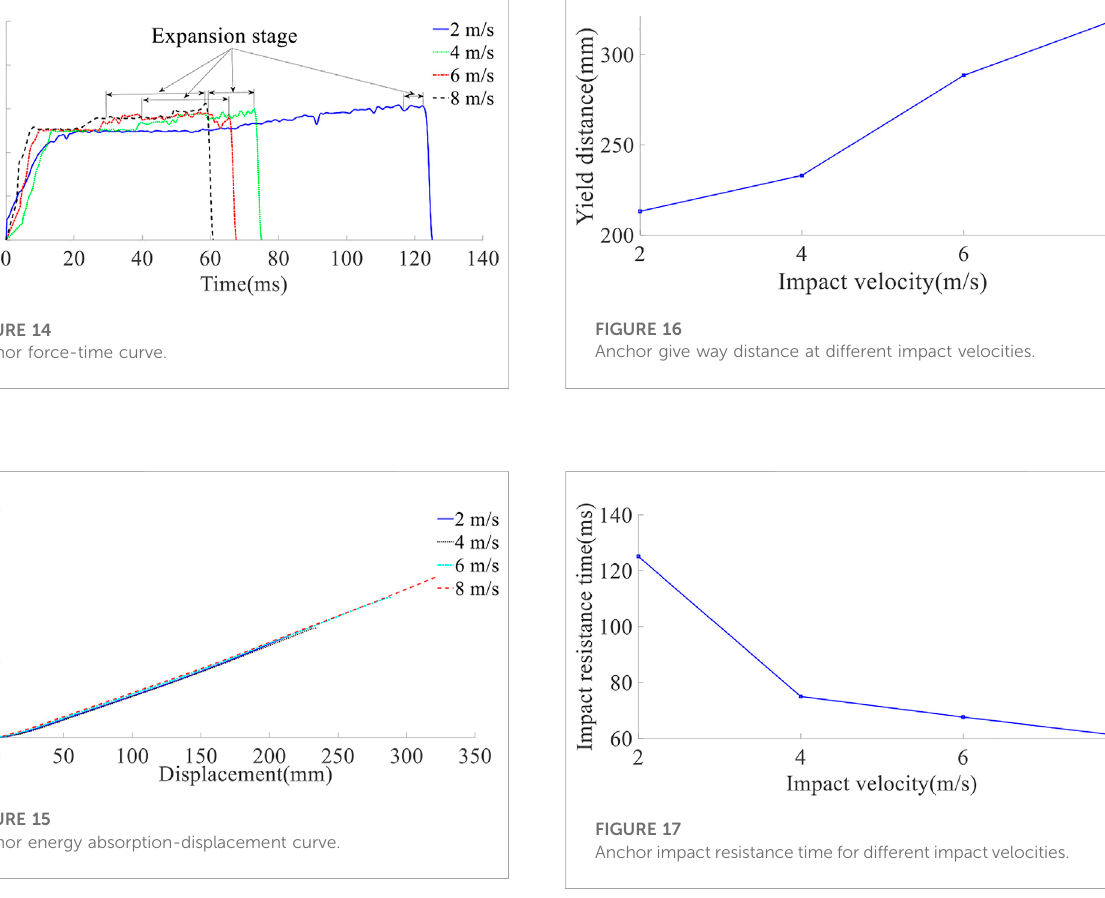
TABLE 4 Mechanical properties of anchor bolts at different impact velocities. Breaking Impact Yield energy/kJ force/ force/kN kN